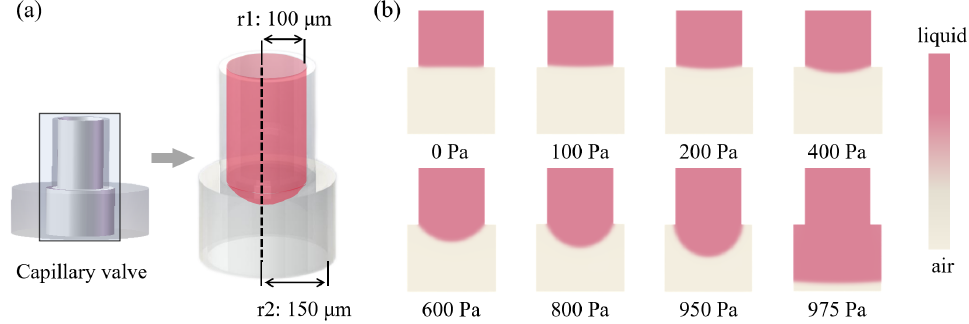
Figure 7. Numerical simulation of critical burst pressure of capillary valve. ( a ) The capillary valve modeling. ( b ) Deformation of the lower meniscus under different external pressures (liquid: pink; air: